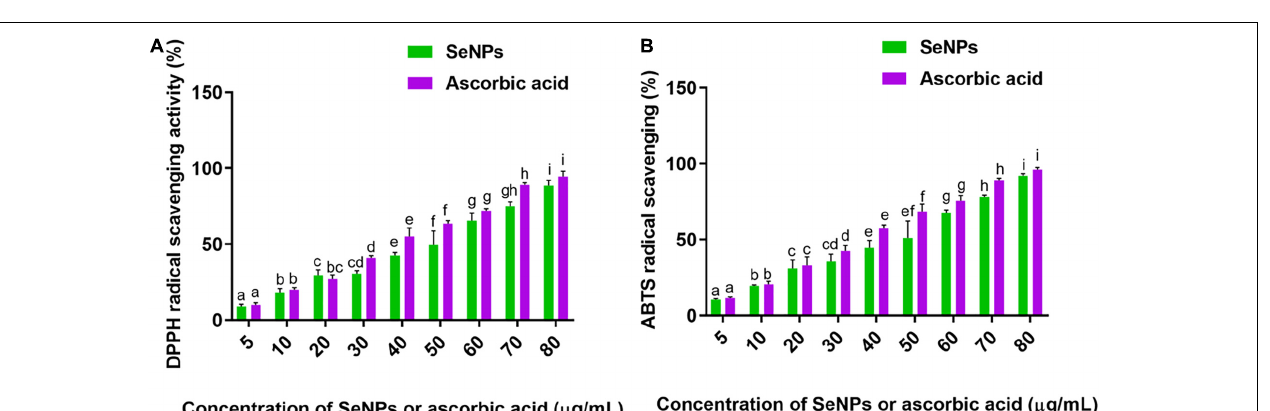
FIGURE 7 | (A) SEM image of SeNPs. (B) HR-TEM image of SeNPs.